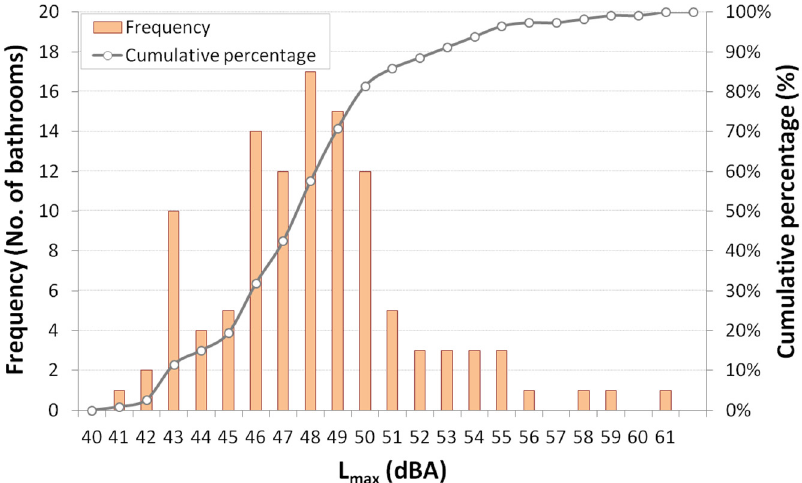
Figure 9. Frequency distribution and cumulative percentages of water supply and drainage noises (L AFmax ) in the bathrooms of the lower floor from the use of the sanitary wares ( N = 113).